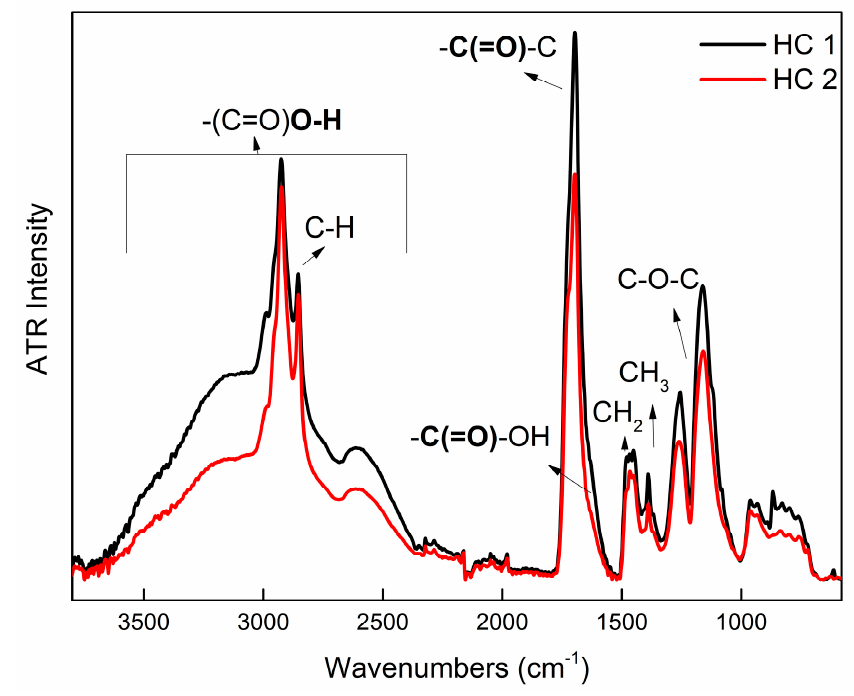
Figure 3. FTIR spectra of the HCs in solid state.